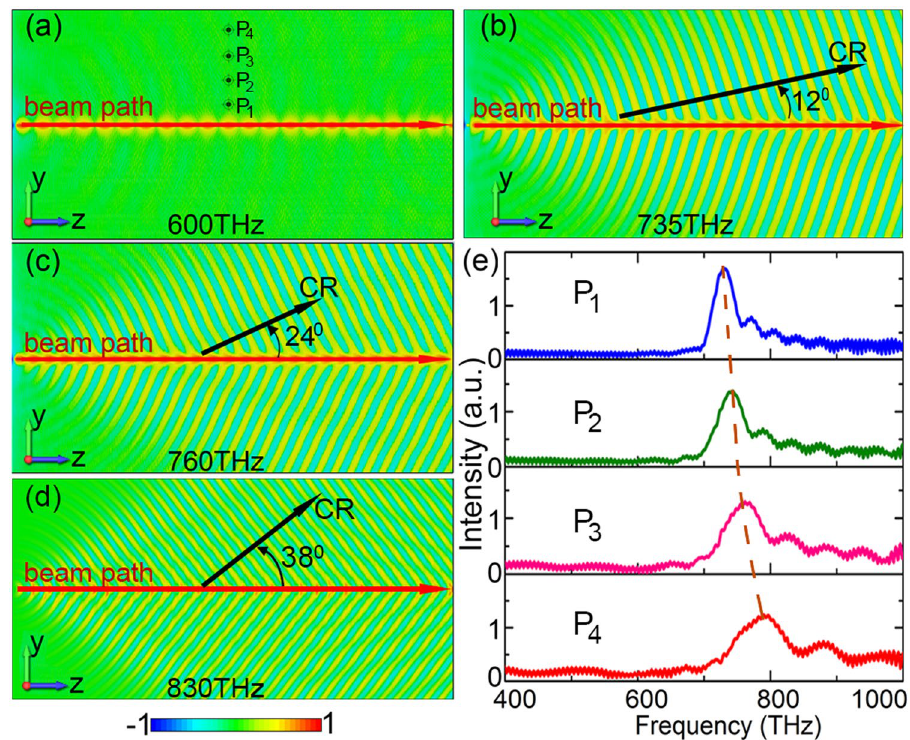
Figure 2. Simulation results of contour maps and spectra on the nano-film. ( a – d ) are contour maps of the E x field on the surface of the nano-film for waves respectively with frequencies of 600 THz, 730 THz, 760 THz, and 830 THz. ( e ) The spectra detected at positions of ‘ P 1 ’–‘ P 4 ’ in Fig.